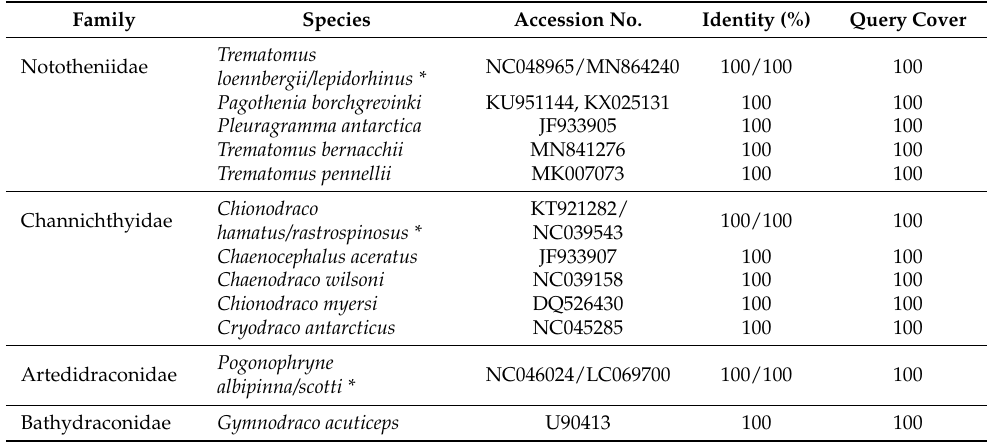
Table 5. Fish species determined using miniFish metabarcoding in Ross Sea.